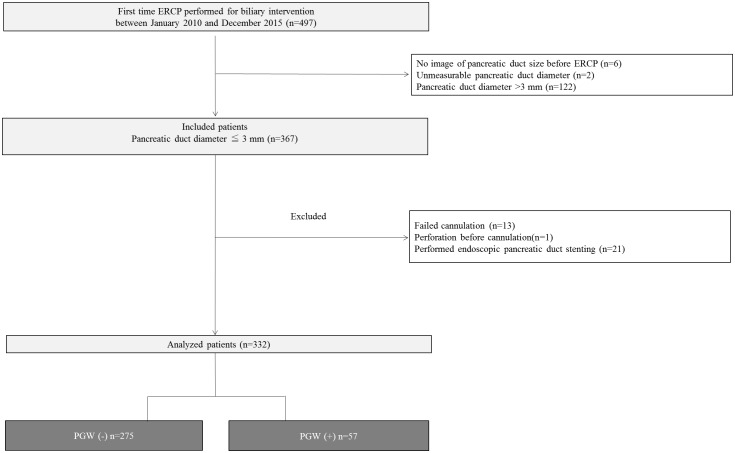
Diagram of the study design.ERCP, endoscopic retrograde cholangiopancreatographyPGW, pancreatic guidewire placement method.